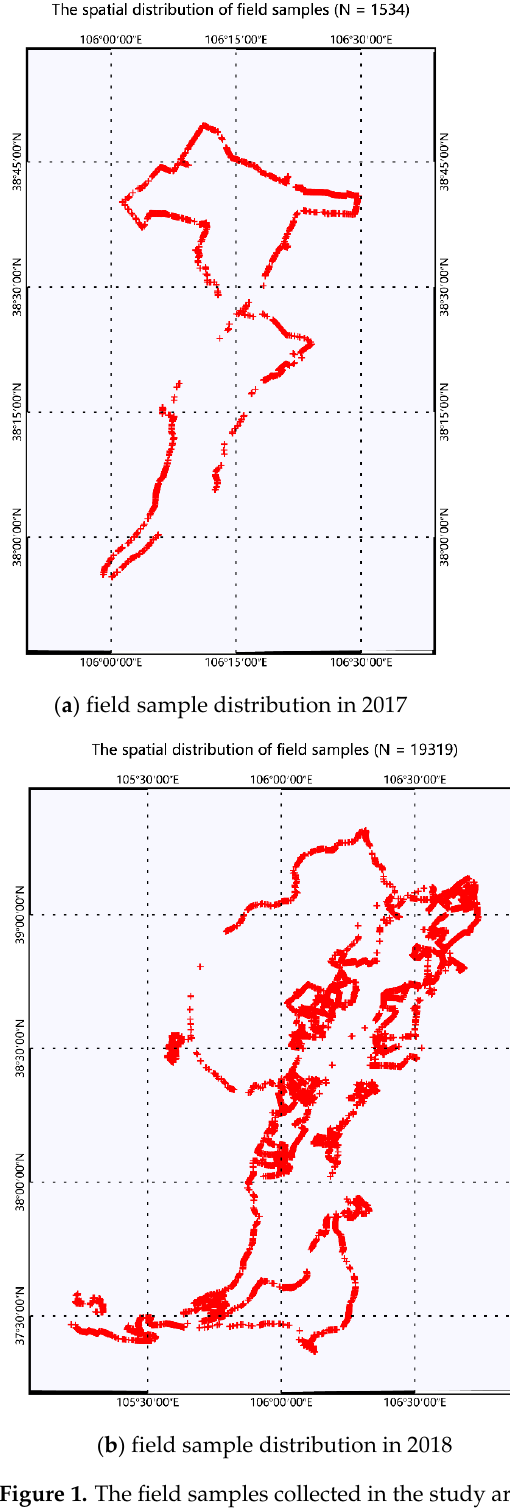
Figure 1. The field samples collected in the study area. In addition to the field campaigns, more spatially well-distributed training samples were obtained by visually interpreting the satellite images. All samples were randomly separated into two datasets at a ratio of 70% (for training) to 30% (for validation). Tables 1 and 2 list the number of samples and the proportion of each crop type for the 15 m GF- 1 and 10 m S-2 pixels. Table 1. The number of training samples for GF-1 at 15 m and the proportion for each crop type. Counts and Proportion 100 Table 2. The number of training samples for S-2 at 10 m and the proportion for each crop type. Counts and Proportion